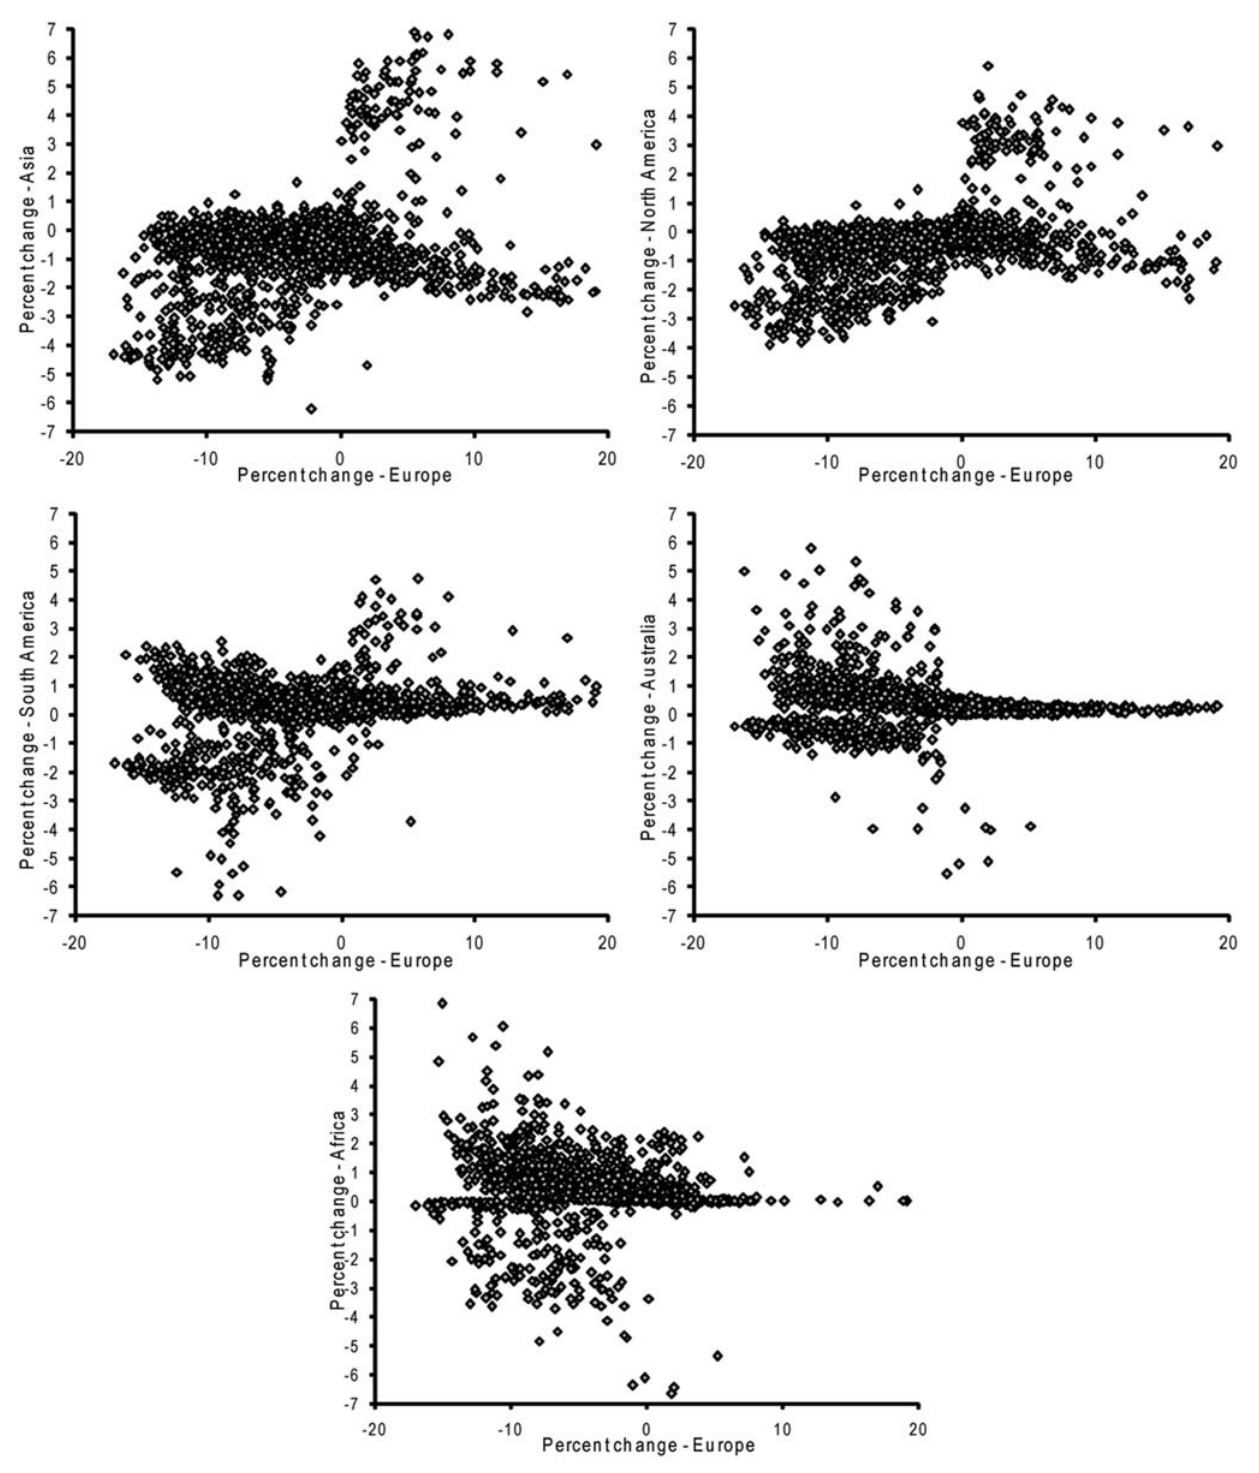
Figure 3. Summary of relationship between projected changes in distributional area on the native (European) distributional area and projected changes in potential distributional area in nonnative areas on five other continents.